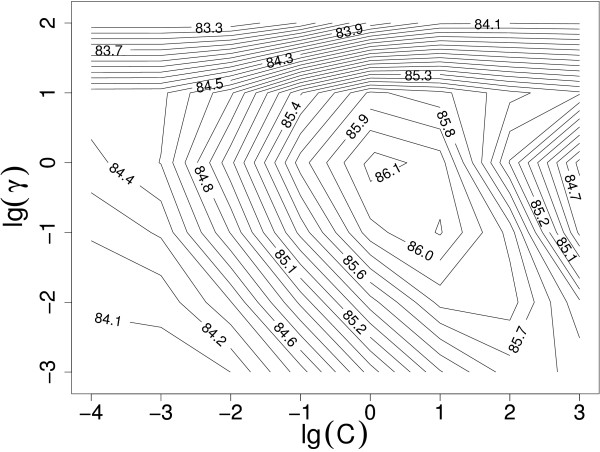
Parameter estimation: The performance of the weighted SVM with the Gaussian kernel as a function of the SVM penalty parameter C and the kernel parameter γ. Both parameters are in a logarithmic scale. The best performance is reached at C = 1 and γ = 1.